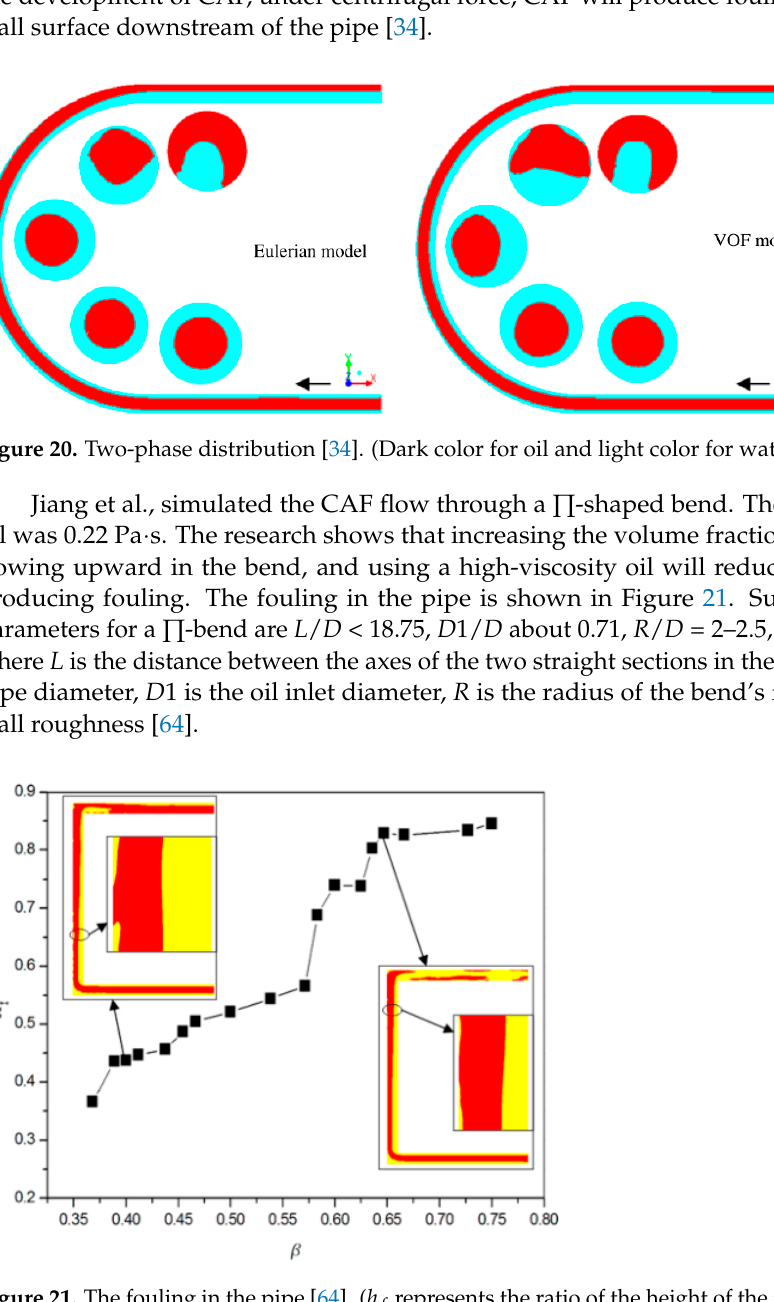
Figure 21. The fouling in the pipe [64]. (h f represents the ratio of the height of the fouling point to the total height of the bend, β represents the volume fraction of the input water. Red for oil and yellow for water.)